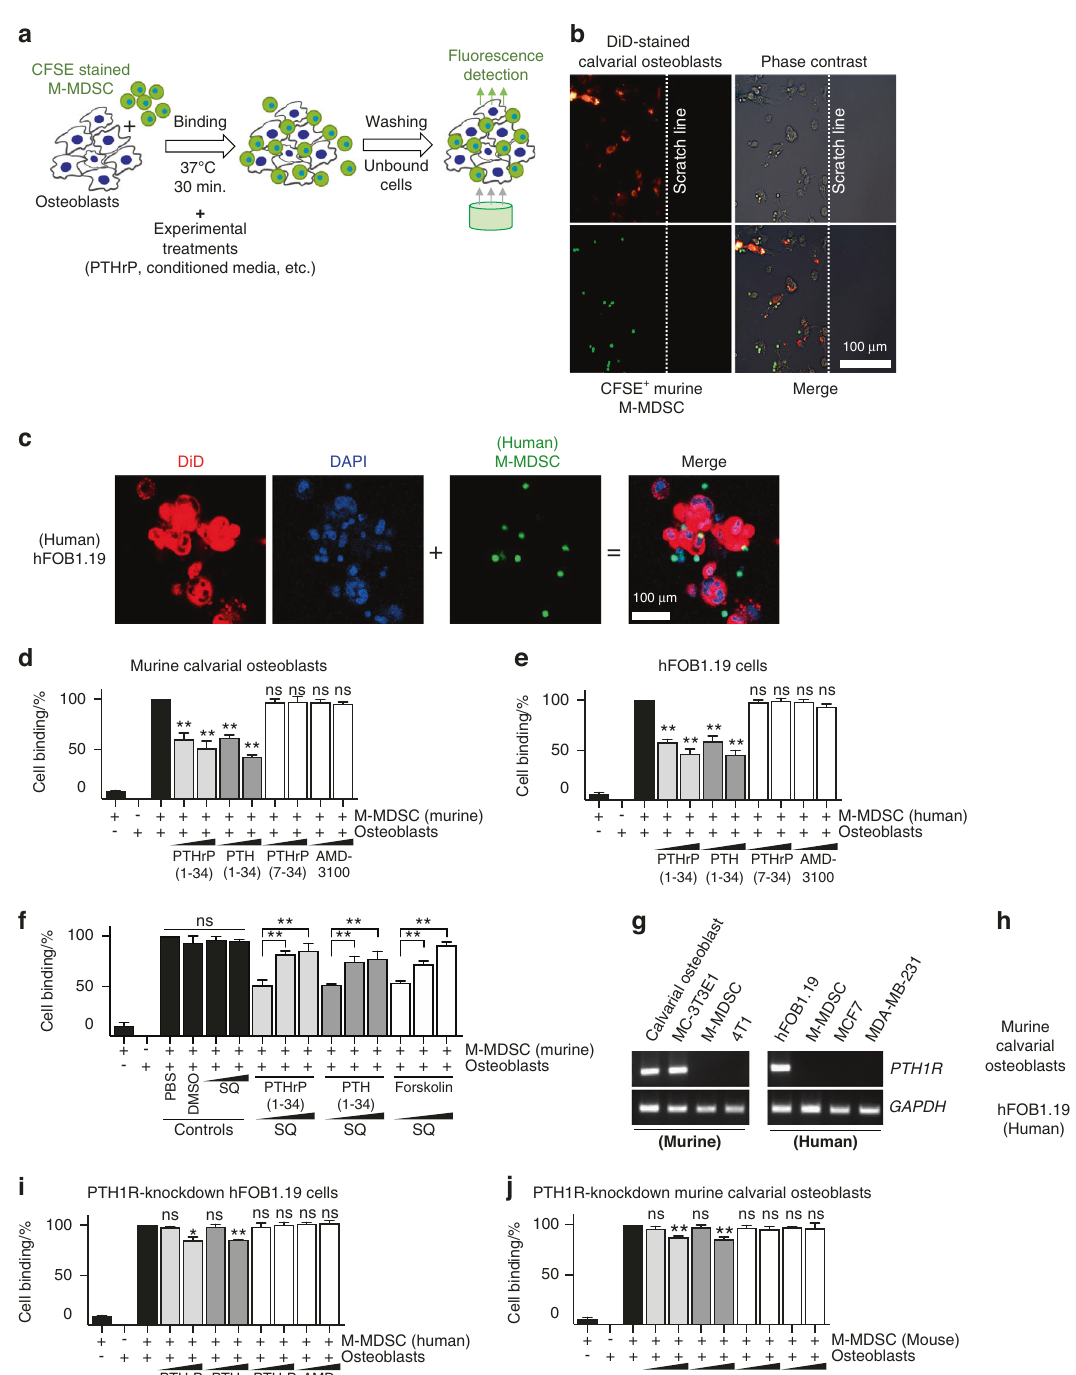
Fig. 2 Activation of osteoblasts via PTH1R ligands (PTH or PTHrP) releases M-MDSCs binding to osteoblasts. a Schematic representation of the in vitro cell binding assay. Murine or human M-MDSCs were isolated by fl ow cytometric sorting from 4T1 tumor-bearing mouse tibia or breast cancer patient blood, followed by CFSE labeling and coculture with primary calvarial (murine) or hFOB1.19 (human) osteoblast monolayer cultures, respectively. b , c Microscopic images of murine primary calvarial osteoblasts ( b ) or human hFOB1.19 ( c ) osteoblasts (Vibrant ® DiD-NIR dye; orange) cocultured with murine or human M-MDSCs (CFSE; green), respectively, for 15min. d , e Addition of rhPTHrP(1-34) or rhPTH(1-34), both functional ligands for the common receptor PTH1R, released M-MDSC binding to osteoblasts. f Effects of rhPTHrP (1-34, 1 or 10 nmol·L − 1 ) or rhPTH (1-34, 1 or 10 nmol·L − 1 ) on M-MDSC and osteoblast binding release were inhibited by SQ22,356 (SQ, 0, 10 or 100 μ mol·L − 1 ), an inhibitor of adenylate cyclase downstream of PTH1R. g Semiquantitative RT ‒ PCR showing PTH1R expression in murine (primary calvarial or MC3T3E1 cell line) and human hFOB1.19 osteoblasts but not in M-MDSCs or breast tumor cells (4T1 murine or MCF7 and MDA-MB-231 human cell lines). h – j PTH1R knockdown blunted the effects of PTHrP (1-34, 1 or 10nmol·L − 1 ) or PTH (1-34, 1 or 10 nmol·L − 1 ) on MDSC-osteoblast binding release. h Western blotting analysis showing decreased expression of PTH1R in murine or human osteoblasts transduced with PTH1R-speci fi c shRNA expression lentiviral vectors. Untreated or scrambled sequence expression vector-transfected cells were used as controls. i , j In vitro cell binding assay using PTH1R knockdown osteoblasts. Data are the mean ±SEM ( n = 3 per group). ** P <0.01; ns nonsigni fi cant. One-way ANOVA with multiple group